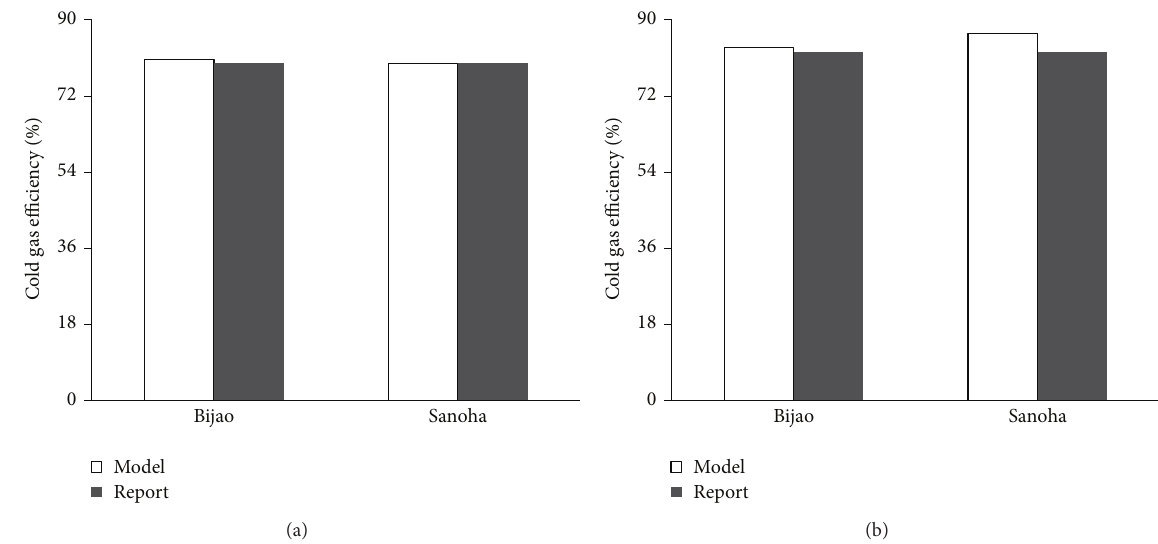
Figure 11: Cold gas efficiency (%). Comparison between simulated and reported data for two Colombian coals; (a) slurry feeding technology and (b) dry feeding technology.